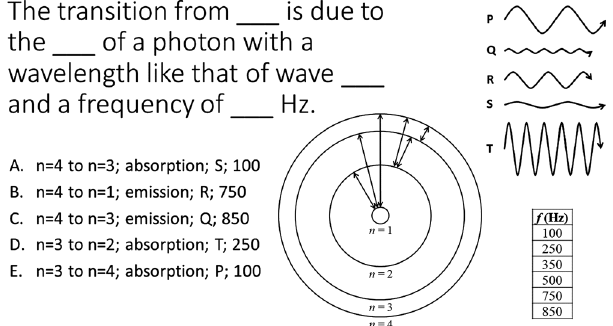
FIG. 5. FIQ integrating electromagnetic radiation with the Bohr model of the atom.